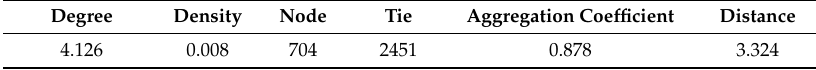
Table 1. Attributes of the elements of urban comprehensive carrying